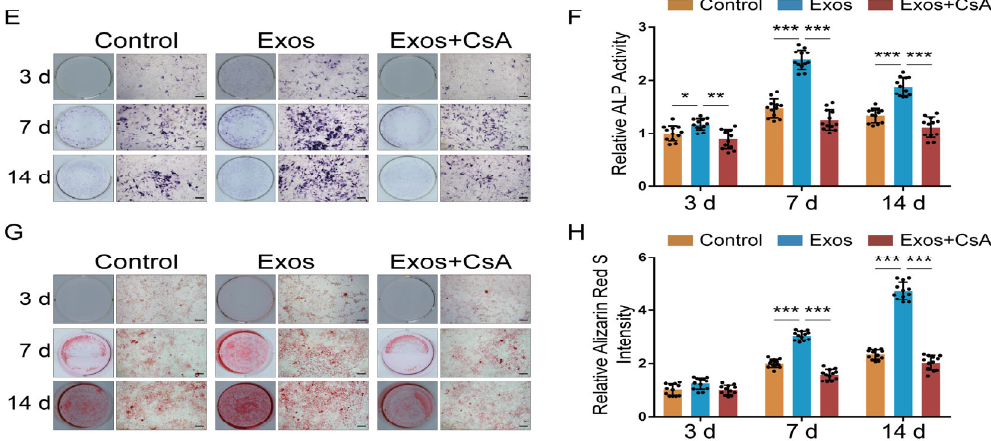
Figure 6. BMSC-Exos promoted osteogenic differentiation of MC3T3-E1 cell through mitophagy. ( A , B ) Western blot assay and quantification of osteogenesis-related genes (PINK1, Parkin and LC3- I/II) in MC3T3-E1 cells treated with PBS (Control), BMSC-Exos (Exos) or BMSC-Exos and CsA (Exos + CsA) ( n = 3). ** p < 0.01; *** p < 0.001. ( C , D ) Representative LC3 immunofluorescence staining (LC3 stained with red and nuclei stained with blue) and quantitative results of LC3 intensity ( n = 12). *** p < 0.001. Bar: 10 µ m. ( E , F ) ALP staining was examined and activity of ALP was analyzed by ALP activity assay kit ( n = 6). * p < 0.05; ** p < 0.01; *** p < 0.001. Bar 100 µ m. ( G , H ) ARS staining was performed and (H) quantified using a microplate reader at 562 nm ( n = 6). *** p < 0.001. Bar: 100 µ